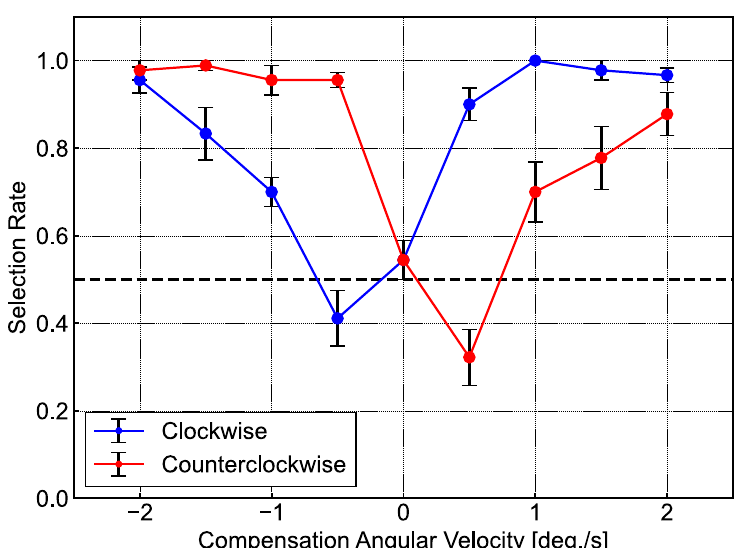
Fig 4. Results of Experiment 1. Each value indicates results averaged across the subjects. The horizontal axis presents the compensation angular velocity for Δ θ , and the vertical axis indicates the average of the selection rate (SR) for subjects for choosing the compensated image. Here, the lower the SR, the more effective reduction of the RSI effects by the system. The blue line denotes the results for the CW images, and the red line gives the results for the CCW images. The original data are available in the Experiment 1 Table of the (S2